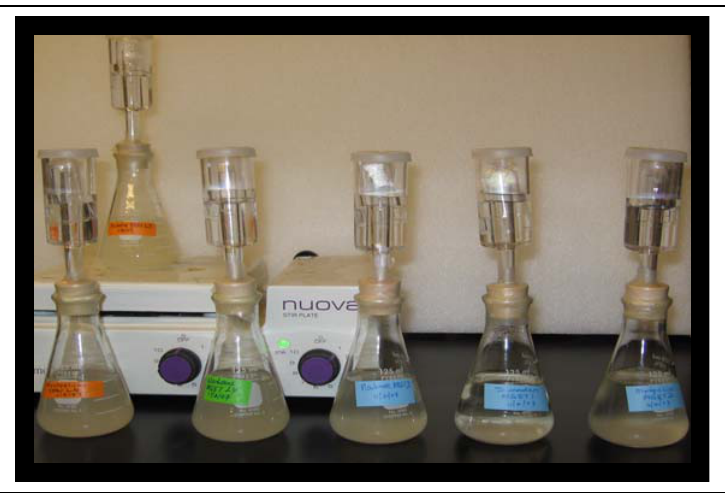
Figure 3. Fermentation setup showing that each flask was sealed with an air lock filled with sterile water to keep the culture under anaerobic conditions. Cultures were stirred daily to re-suspend the settled cells and to remove carbon dioxide from the